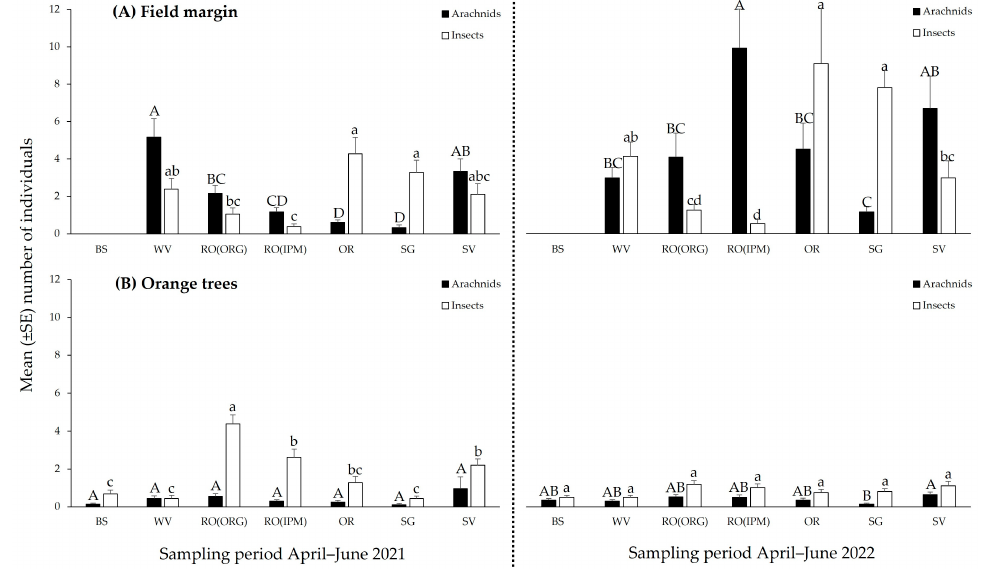
Figure 7. Total abundance (mean ± SE) of arachnid and insect predators ( A ) in field margins, ( B ) on orange trees in orchards with different field margin management: BS—bare soil; WV—weed vegetation; RO(ORG)—rosemary hedgerow (organic orchard); RO(IPM)—rosemary hedgerow (IPM orchard); OR—oregano hedgerow; SG—sage hedgerow; SV—savory hedgerow. Identical letters above the error bar indicate no statistically significant differences among orchards.